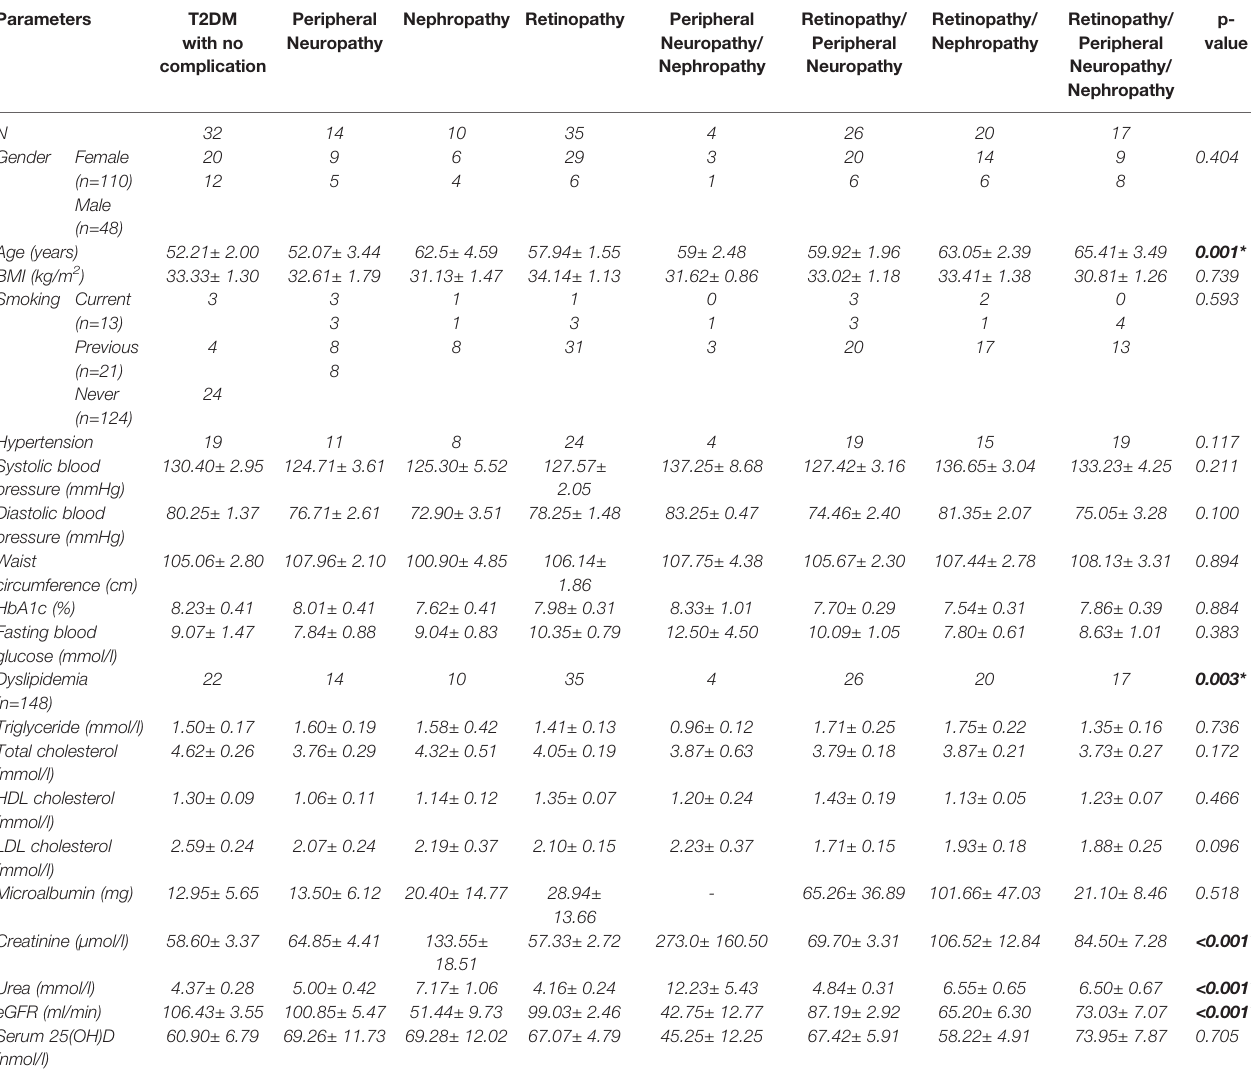
TABLE 1 | Demographic, clinical and laboratory characteristics of T2DM with and without various complication combinations.